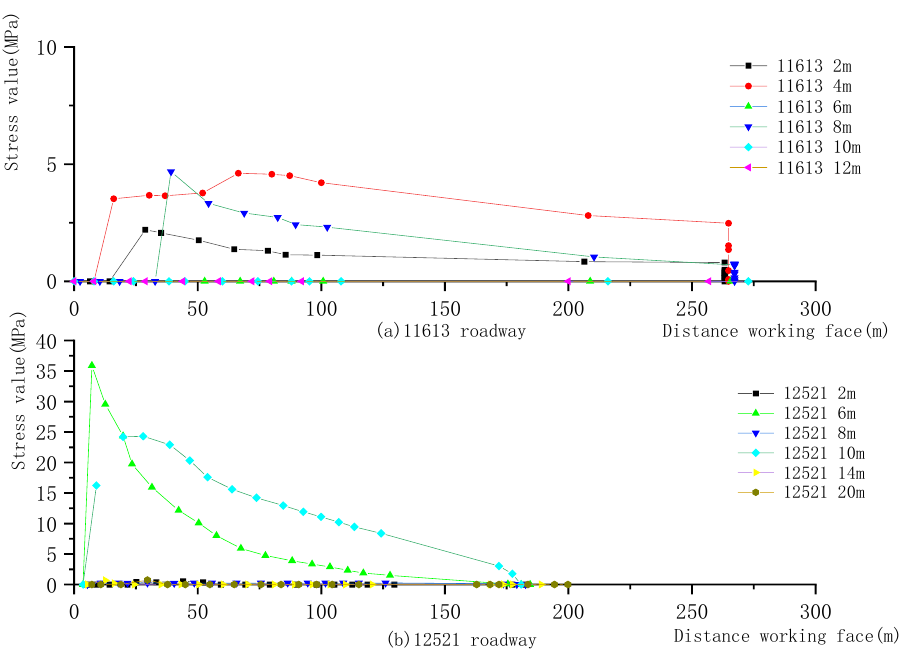
Figure 12. Comparison diagram of horizontal stress at different depth measuring points at low side. ( a ) 11613 roadway; ( b ) 12521 roadway.